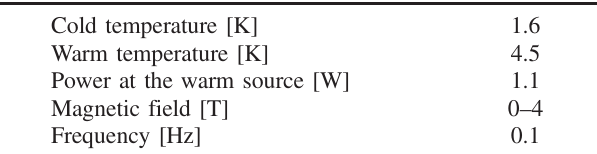
TABLE IV. Small scale prototype parameters.